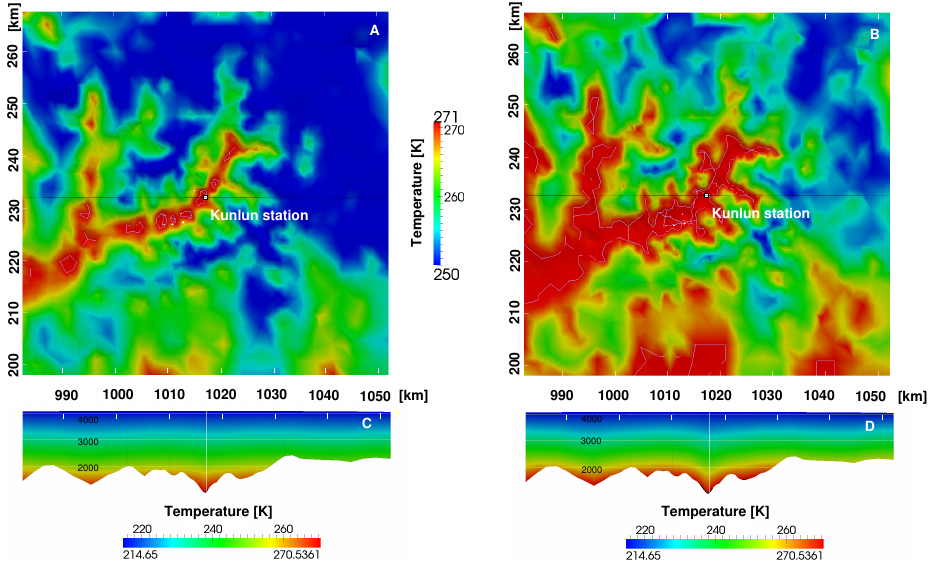
Figure 3. Basal and vertical temperature distribution for 50mWm − 2 ( A and C ) and 60mWm − 2 ( B and D ) geothermal heat flux over the 70 × 70km 2 domain for the solid-cone or horizontal girdle with transition depth, z s = 1 / 3 fabric simulations. The vertical temperature distribution is shown in a transect from west to east across the domain cutting through the Kunlun drill site at the centre (black line in upper picture). The vertical coordinate is stretched by a factor of 5. The bedrock areas at pressure-melting point are surrounded by a white contour in plan view pictures and with black bedrock in the vertical cross sections. Note the different colour bar scales for the plan and vertical cross